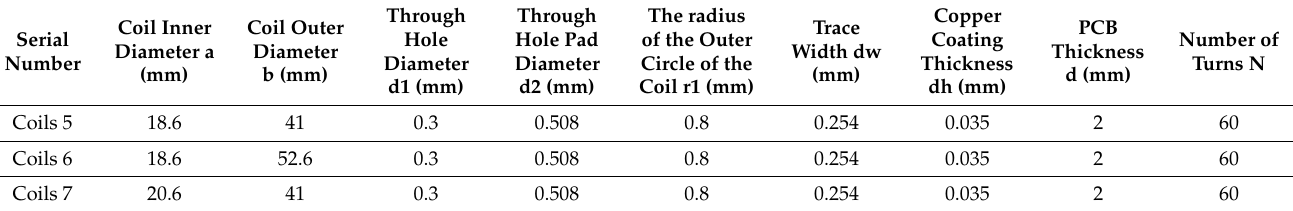
Table 4. Bode diagram of coil 5–7.